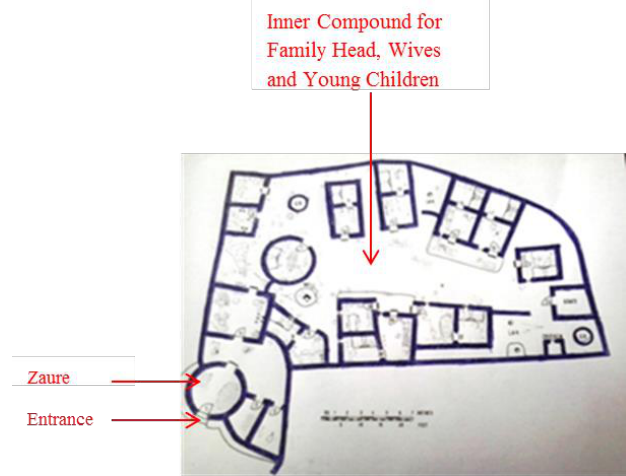
Figure 4i. Plan of a Hausa compound. Source: